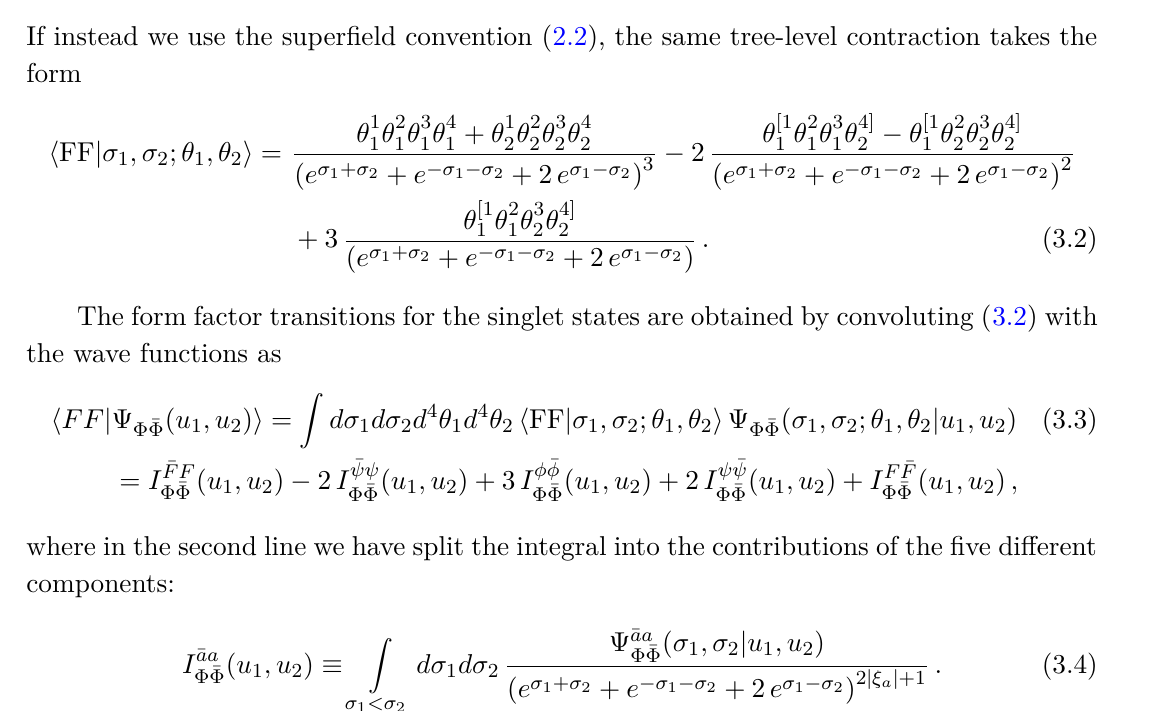
¯Φ( x ( σ 2 )) and Φ ( P ( x ( σ 1 ))) .